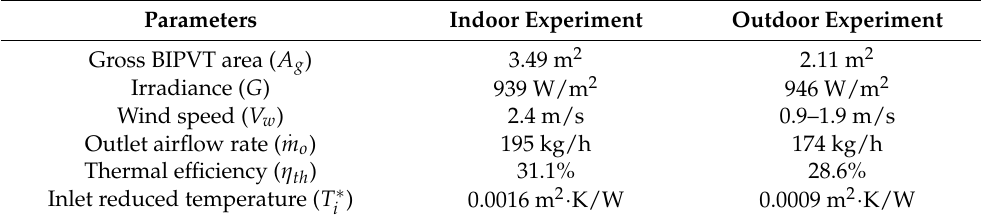
Table 9. Indoor and outdoor thermal performance characterization